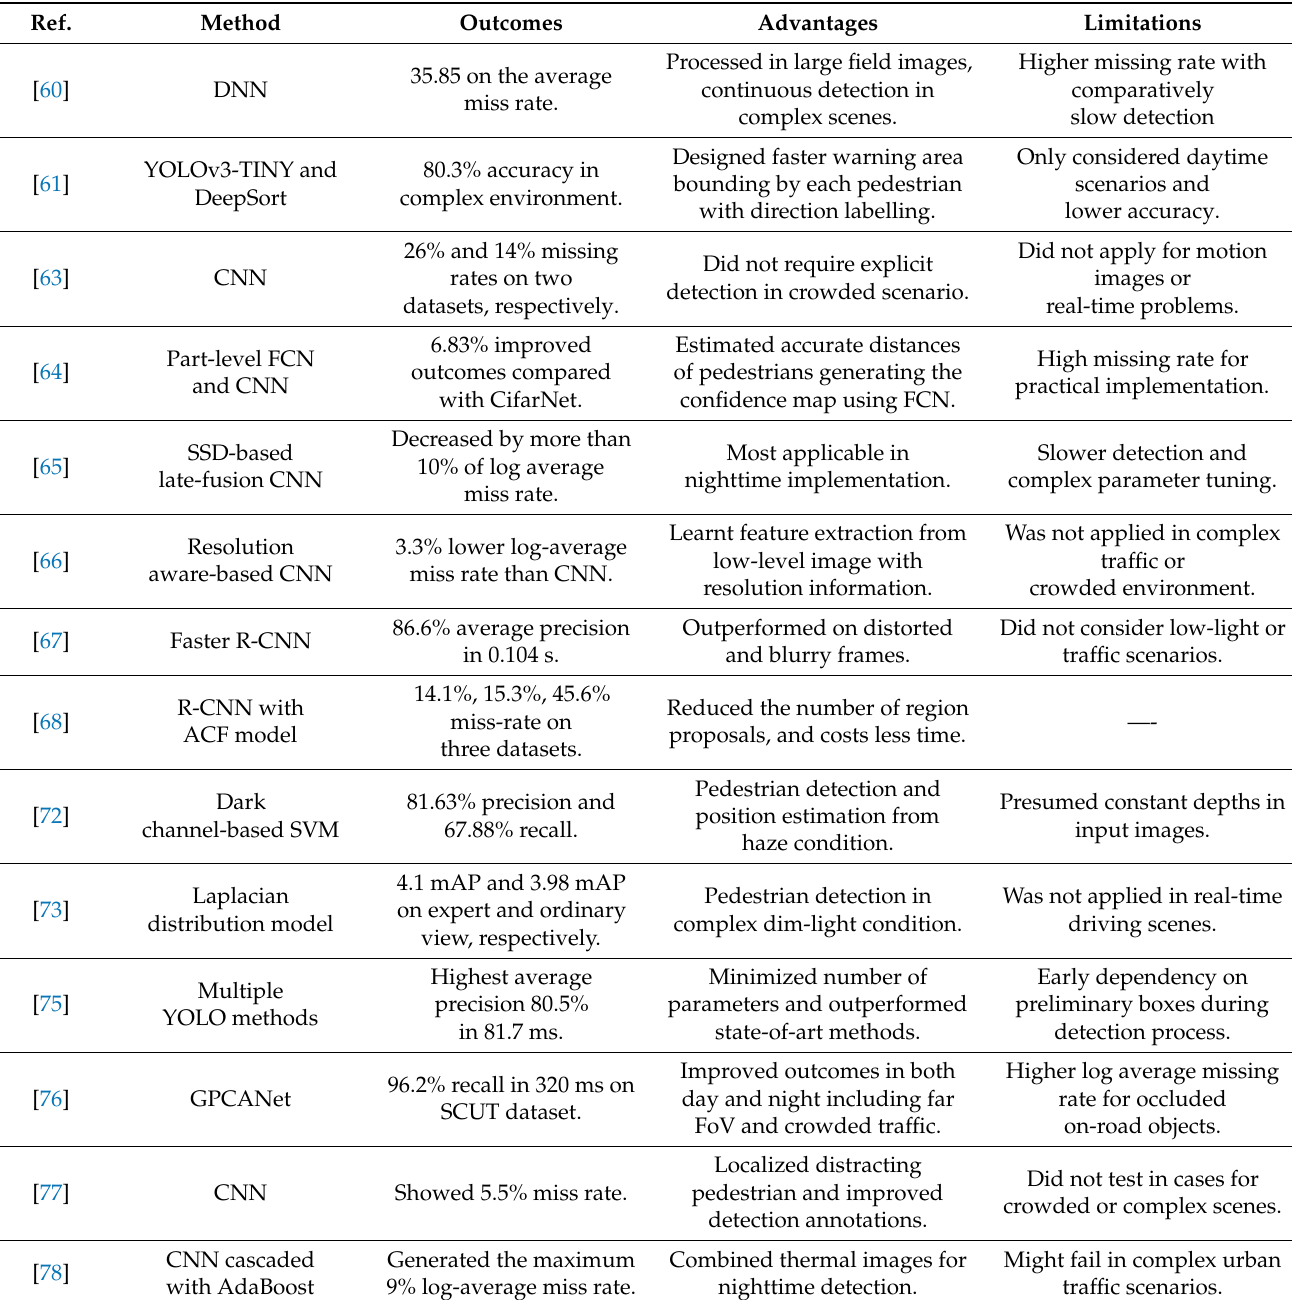
Table 7. Summary of multiple deep learning methods for pedestrian